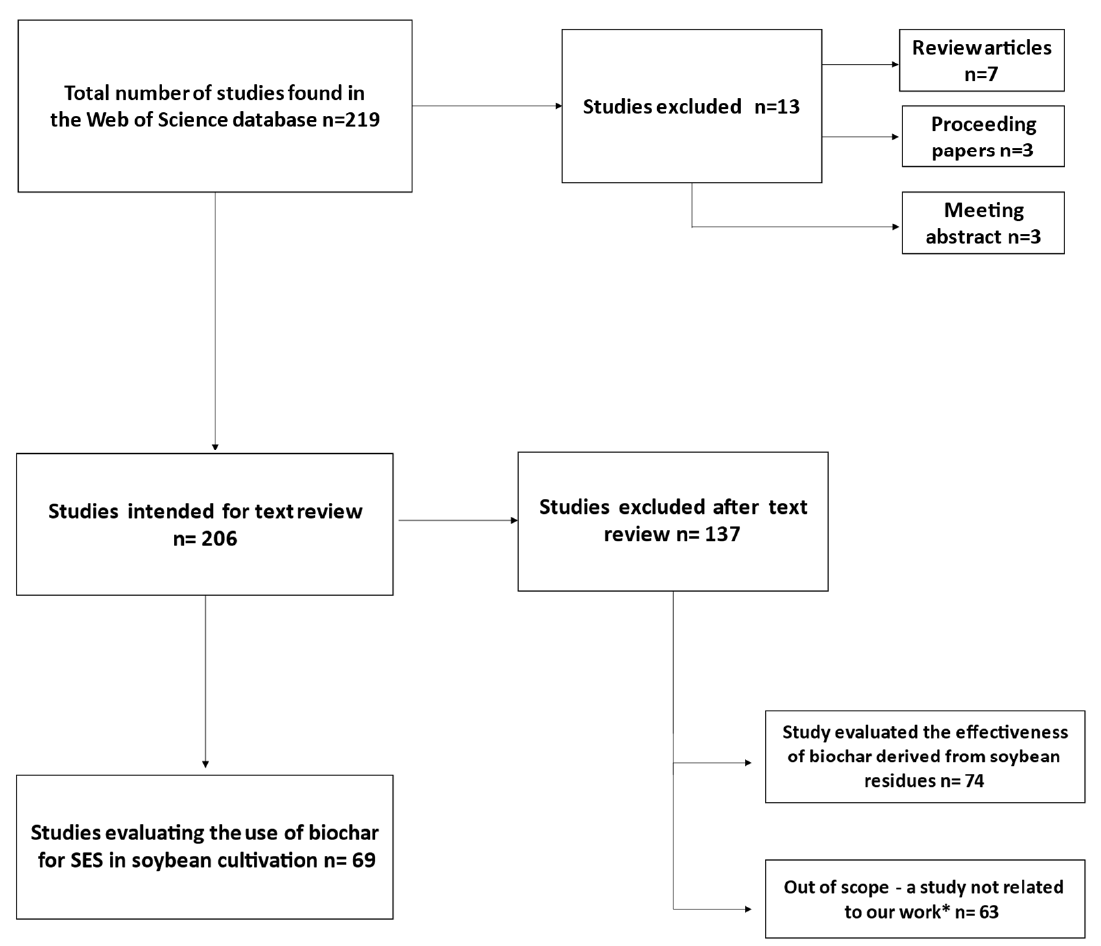
Figure 1. Flow diagram summarizing the systematic literature review for soil ecosystem services (SES) and soybean production with biochar. Out of scope includes, inter alia: modelling n = 6, other parameters evaluated n = 10 and evaluation of biodiesel production from soybean oil n = 10.